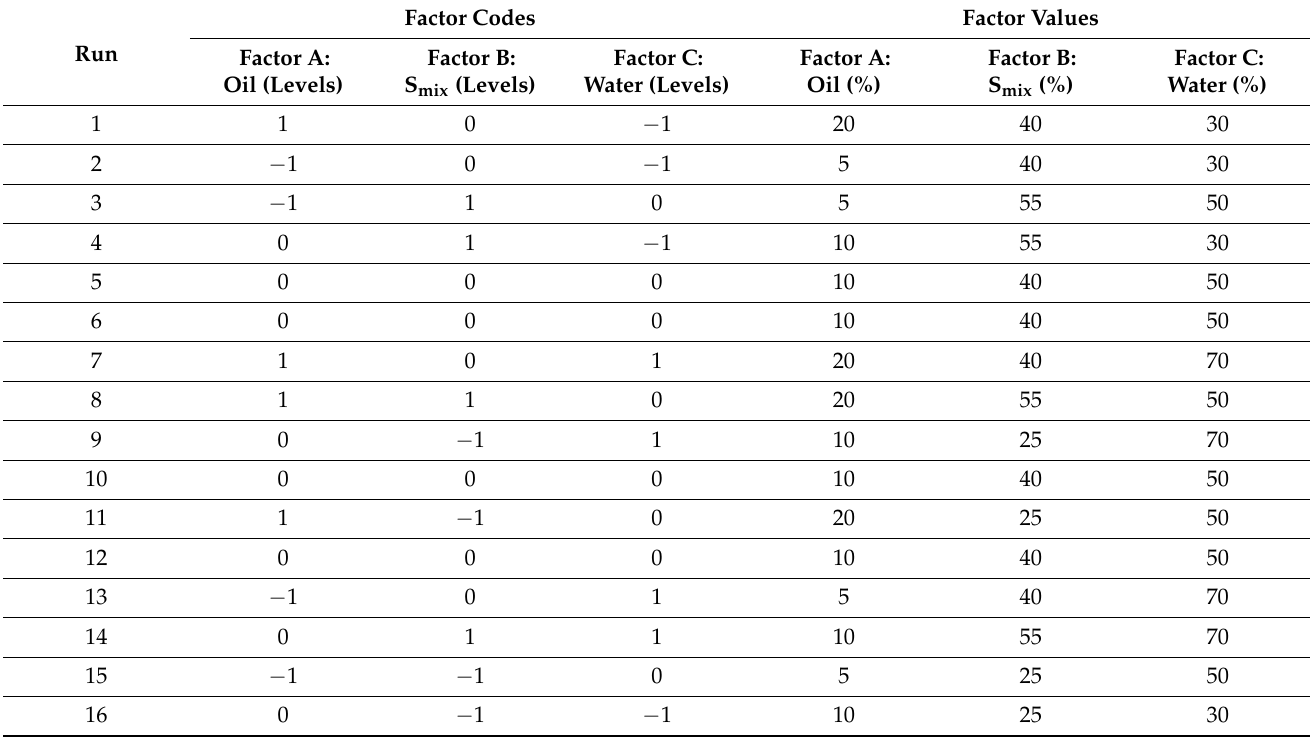
Table 1. Nanoemulsion trials and the independent